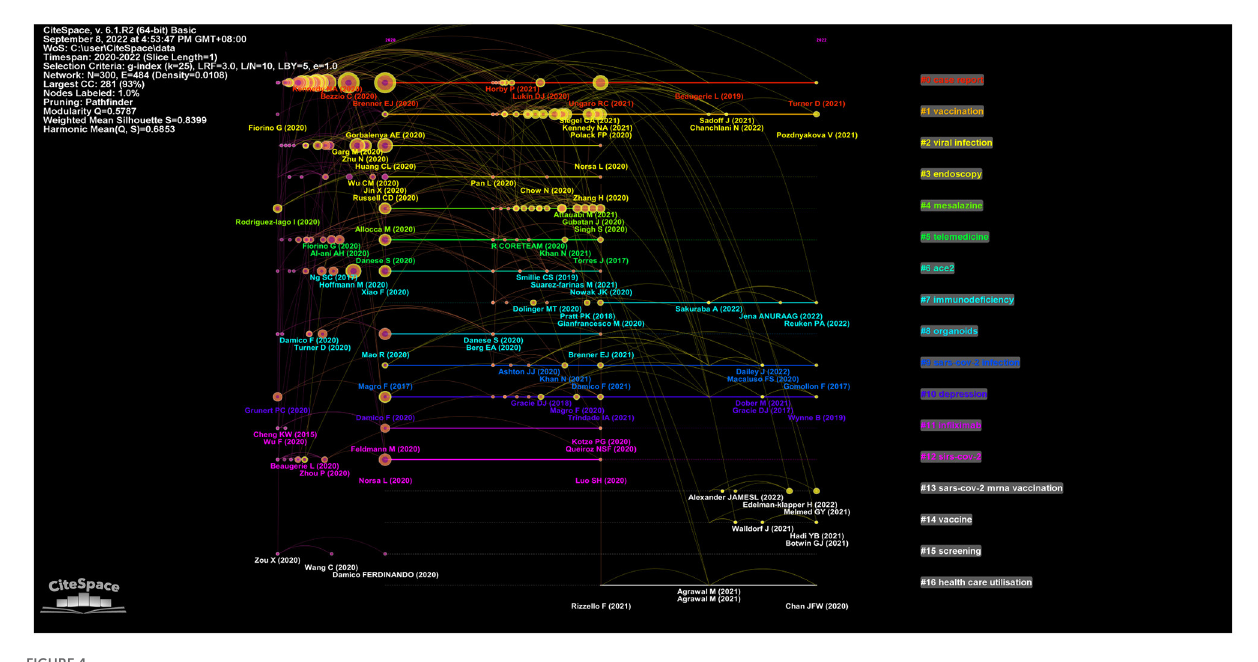
FIGURE4 The cluster analysis of highly co-cited references in the field of IBD and